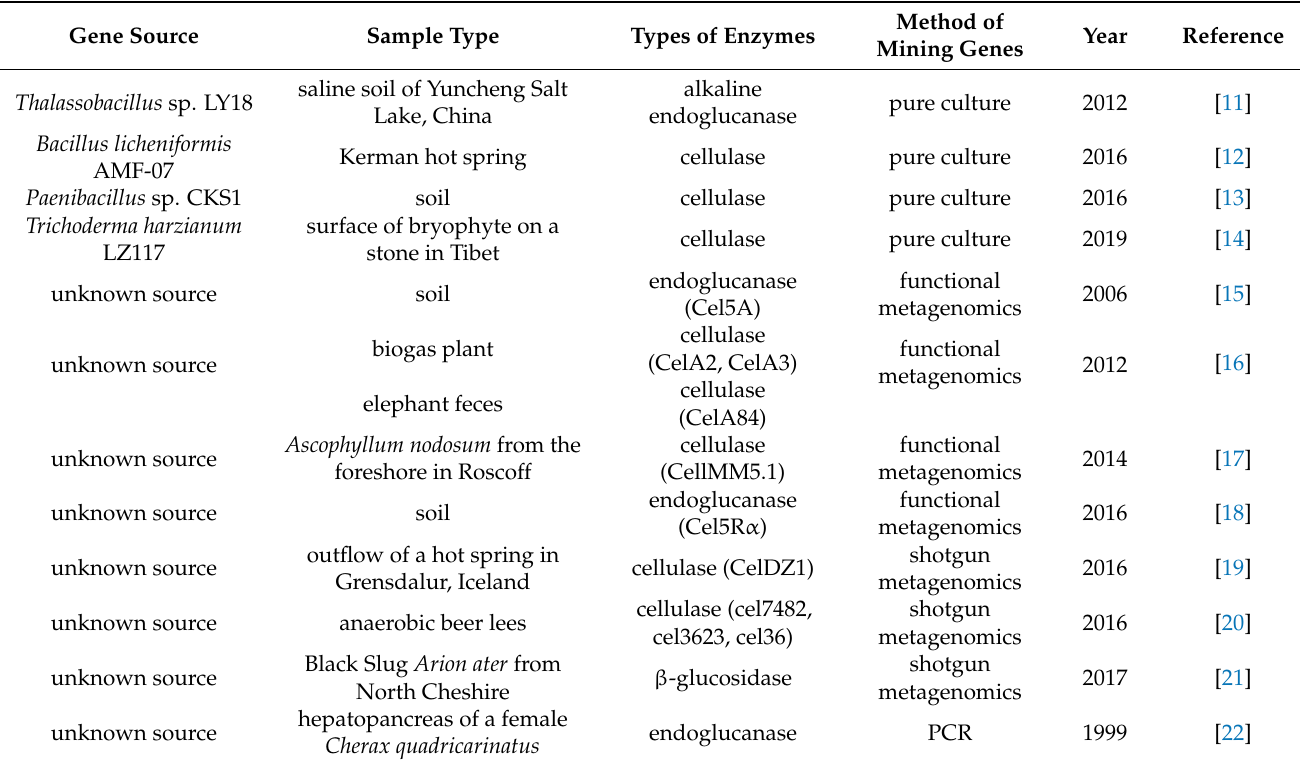
Table 1. Methods for mining new cellulase-producing strains or cellulase gene fragments. Gene Source Sample Type Types of